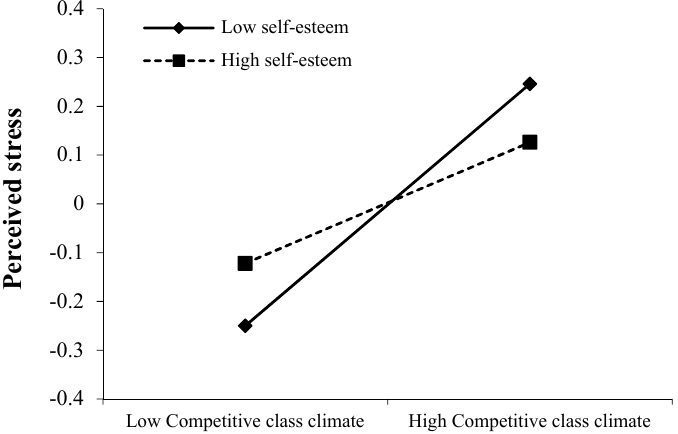
Figure 3. Relationship between perceived stress and competitive class climate as a function of self- esteem.